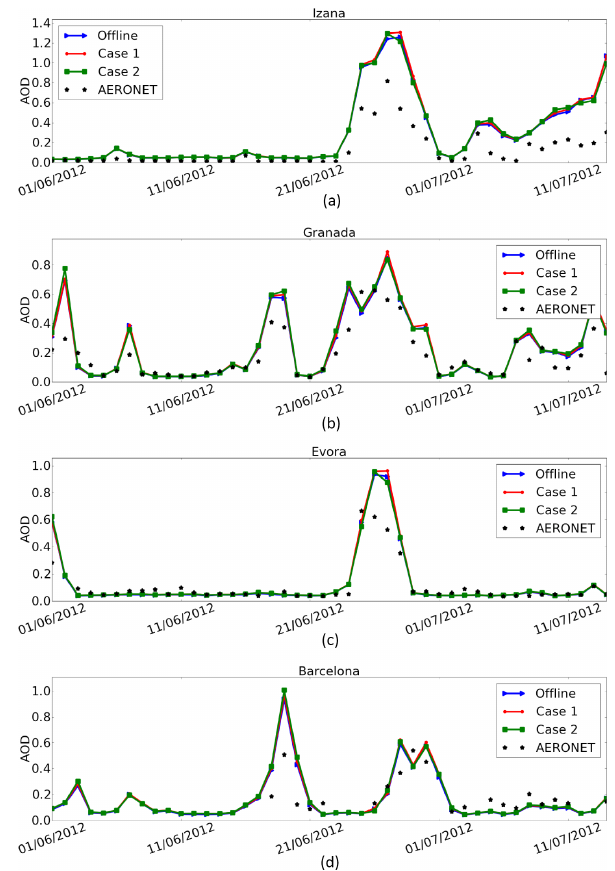
Figure 14. AERONET and modelled AOD time